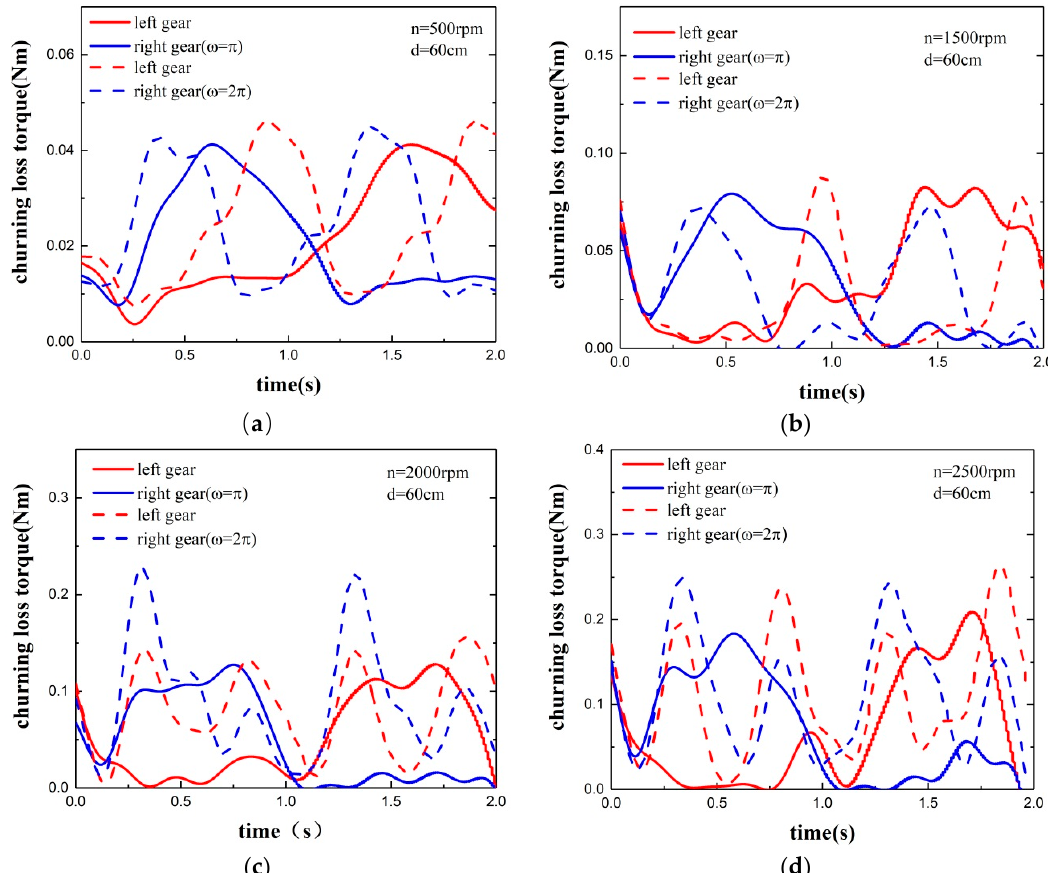
Figure 15. Influence of the frequency of the sinusoidal motion at different rotating speeds. ( a ) Cases with n = 500 rpm; ( b ) Cases with n = 1500 rpm; ( c ) Cases with n = 2000 rpm; ( d ) Cases with n = 2500